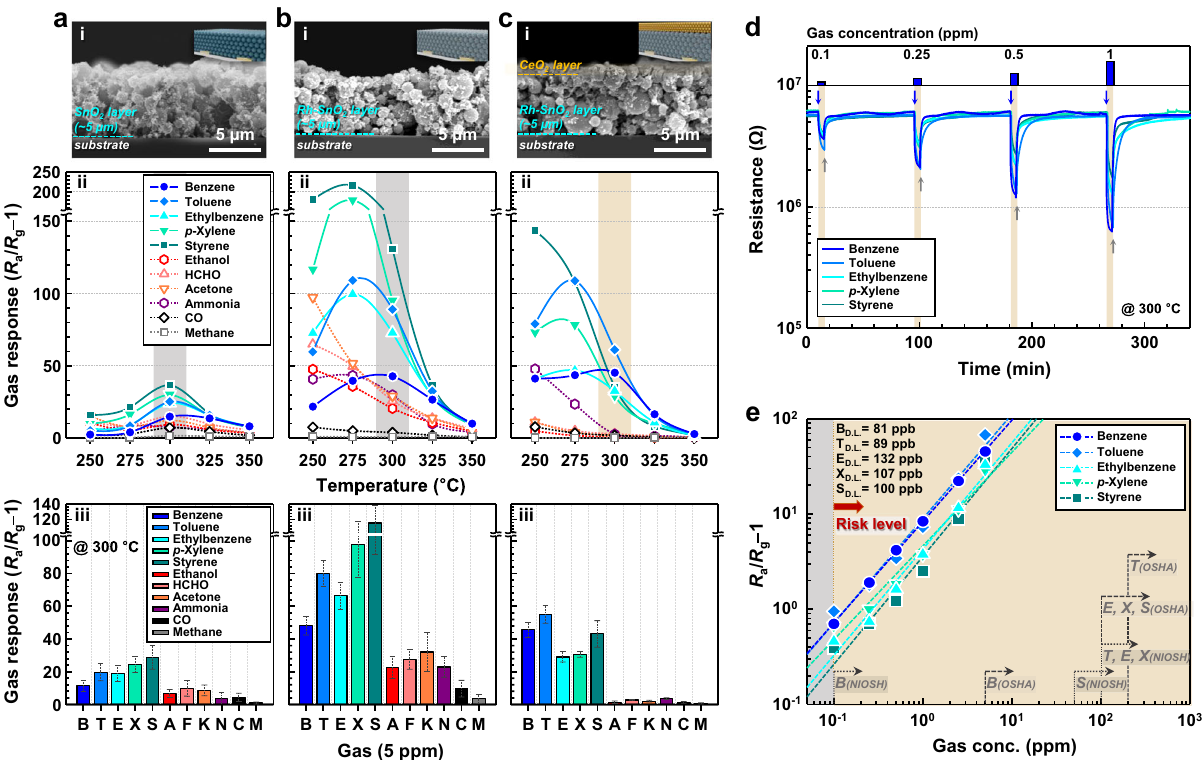
Fig.3|Gas-sensingperformanceofthesamples.a – c Cross-sectionalSEMimages andgas-sensingcharacteristicsofSnO 2 ( a ),Rh – SnO 2 ( b ),and0.4CeO 2 /Rh – SnO 2 ( c ) sensors (analyte gas concentration: 5 ppm; error bars indicate standard deviations for three sensors). d Dynamic gas-sensing transients of 0.4CeO 2 /Rh – SnO 2 sensor exposed to 0.1 – 1 ppm BTEXS at 300°C. e Gas responses as functions of BTEXS concentration and exposurelimitsofvolatilearomaticcompounds based on acute